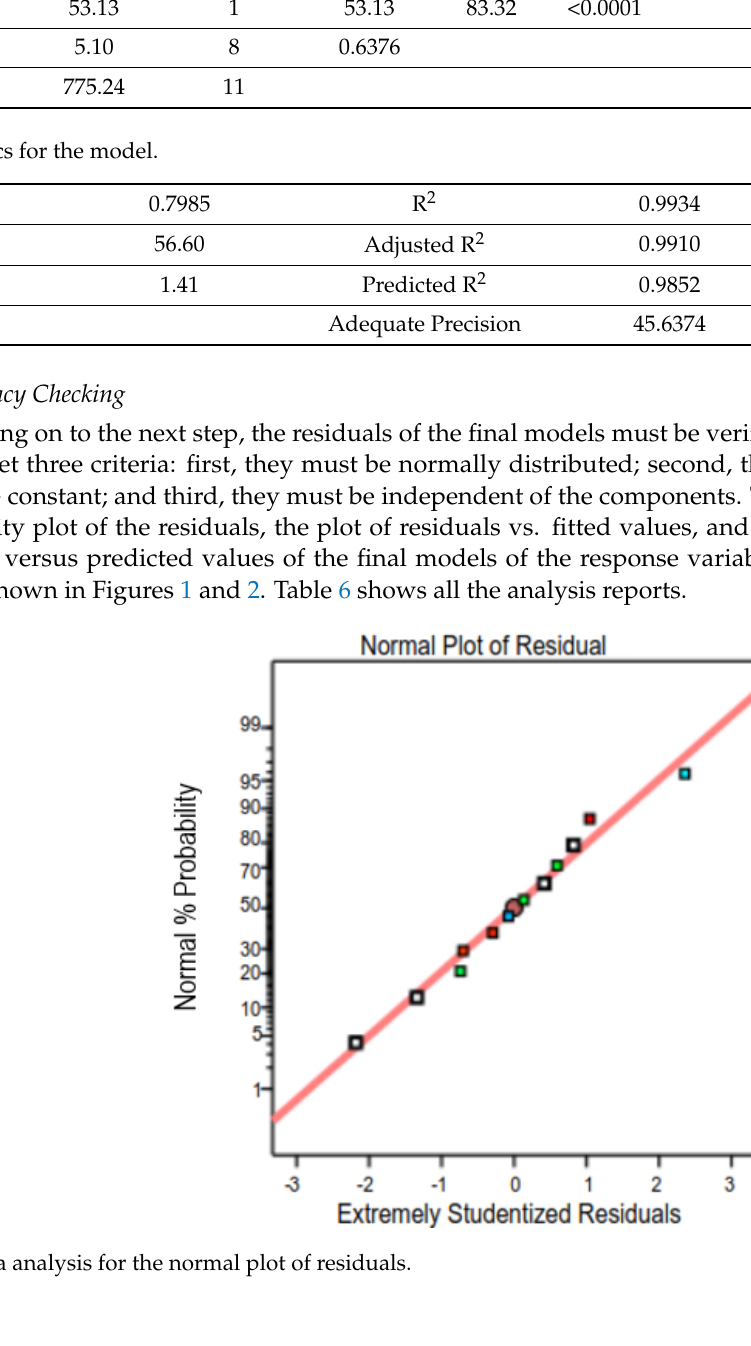
Figure 2. Residual vs. predicted analysis. 3.5. The Two Factors’ Interaction The interaction graph implies both factors have an interception at some point as the lines are not parallel, as Figure 3 shows. The graph shows the interaction; the more the thickness becomes, the more the DC. Therefore, the DC and thickness of the leather have a positive or direct relationship. The couture figure shown in Figure 4 represents whether individual factors or their interaction affect the response. Figure 4 represents how both factors’ interaction influences the drapability. This can be identified by whether the cou- ture is curved (has an effect) or a straight line (does not have an effect).